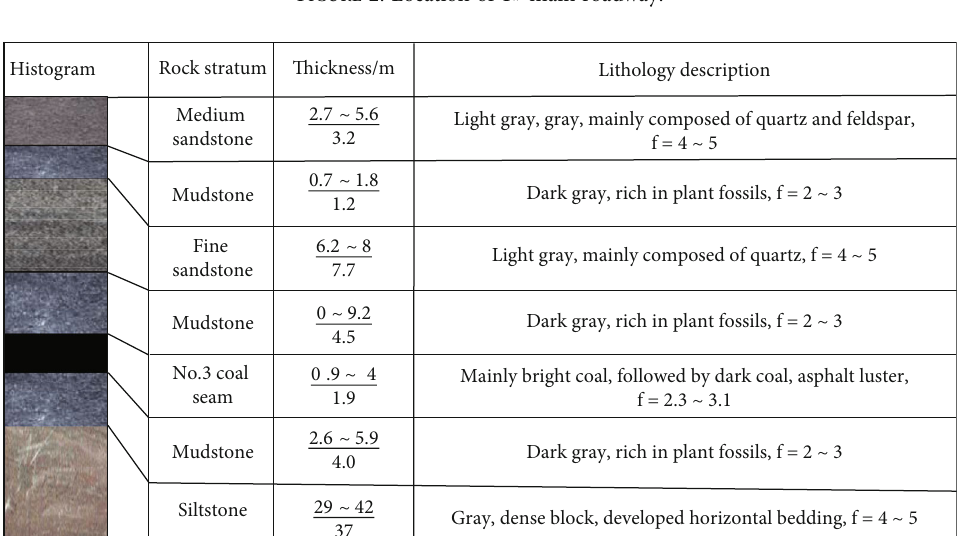
Figure 2: Location of 1# main roadway.